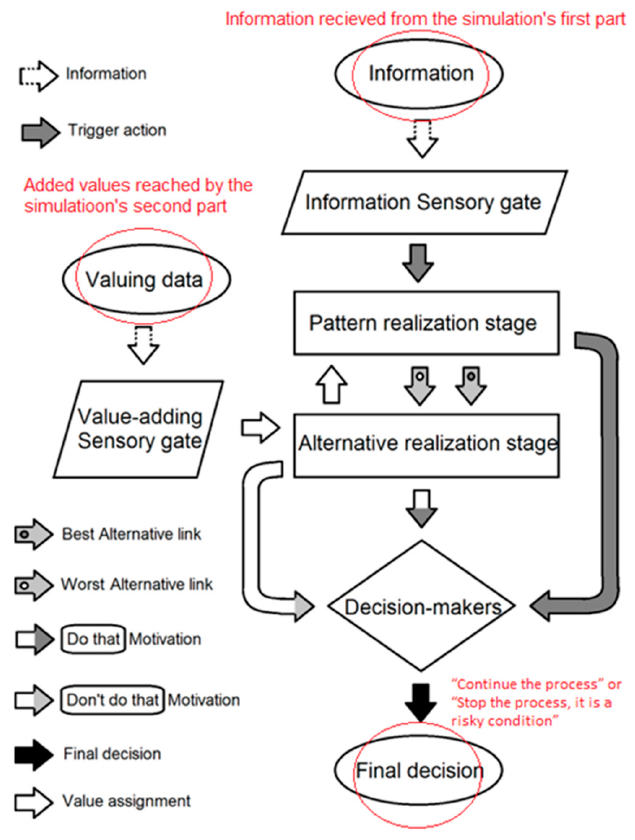
Figure 2. Diagram of the brain-inspired decision-making system [14]. The information-sensory gate receives a new signal from the environment, a pattern of information features (here the situation presented in the simulated part-I), and sends it to the pattern realization stage, which labels its pattern. If a label is linked to any experiences, it activates its attached alternatives at the alternative realization stage. Those alternatives determine the motivation values for the decision-making process. The decision-makers then decide to either “Continue the process” or “Stop the process, it is a risky condition”. After making the decision, the value-adding sensory gate receives the added value signal from part-II and records it for the information pattern’s label. If this new value suggests a new option on top of one of the best or worst alternatives, the option replaces that best (or worst) alternative on that label.